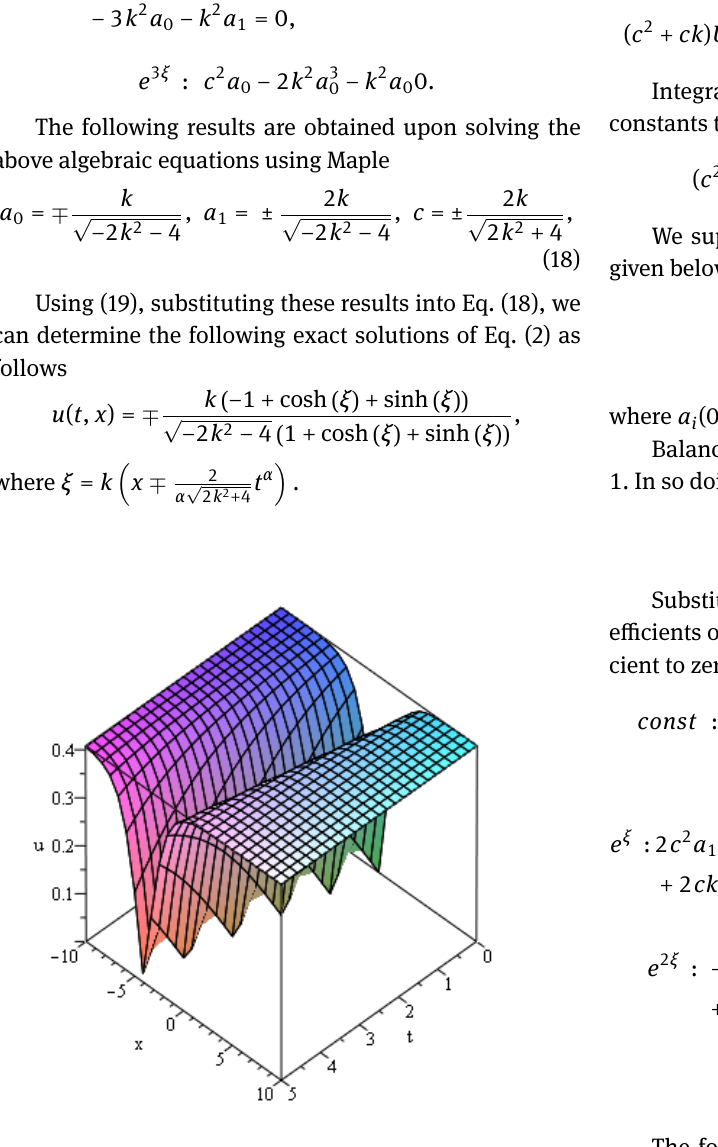
Fig. 2: The obtained soliton solution of Eq. (2) ( | u | ): α = 1; k = −1; −10 ≤ x ≤ 10;0 ≤ t ≤